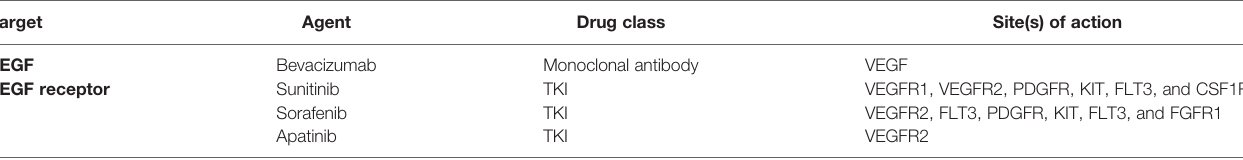
CSF1R, colony-stimulating factor receptor type 1; FGFR1, fi broblast growth factor receptor 1; FLT3, fms-like tyrosine kinase 3; KIT, stem cell factor receptor; PDGFR, platelet-derived growth factor receptor; TKI, tyrosine kinase inhibitor; VEGF, vascular endothelial growth factor; VEGFR1, vascular endothelial growth factor receptor 1; VEGFR2, vascular endothelial growth factor receptor 2.